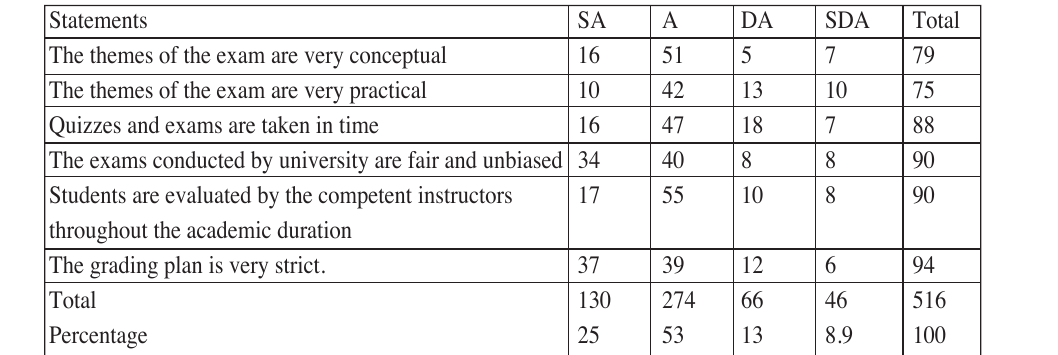
Table No. 8 Most Important Attribute to Maintain the Quality in Independent Variable